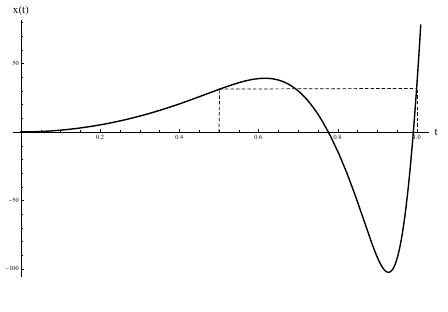
Figure 3. Solution x 2 ( t ) of problem